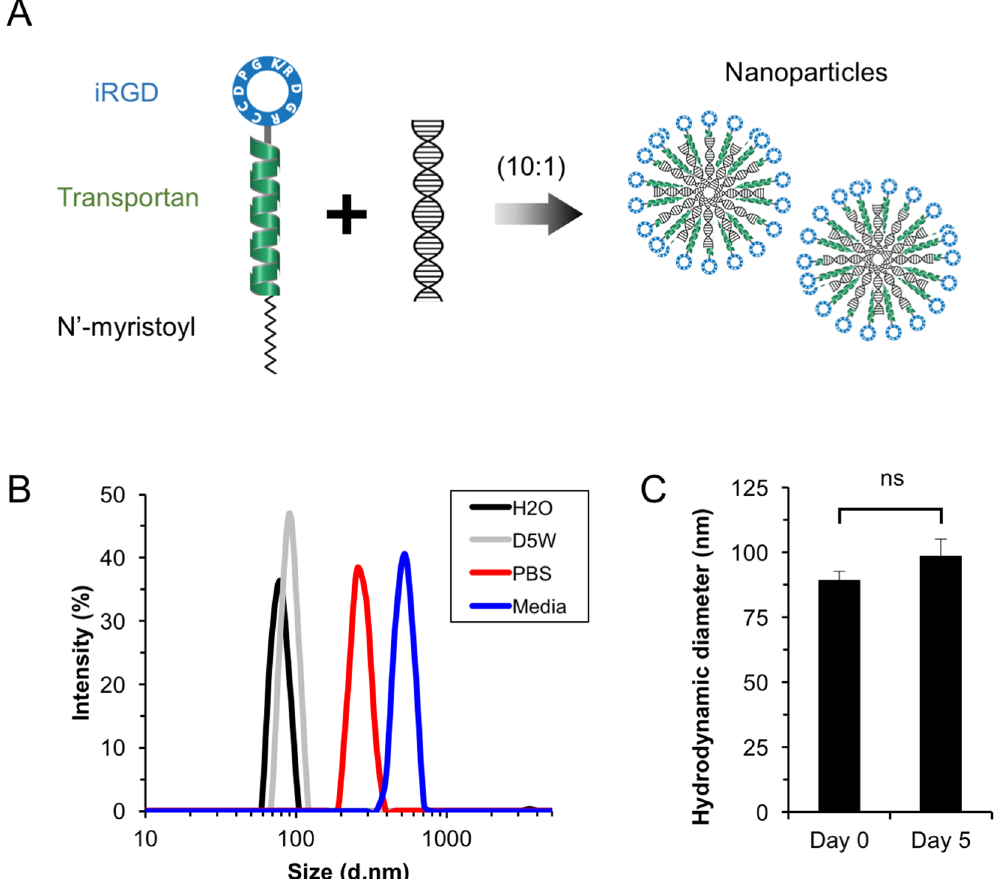
Figure 1. Characterization of iRGD-targeted nanoparticles. ( A ) Schematic of iRGD nanoparticle formation. Tandem peptides consisting of three domains: N-terminal myristoylated acid, cell penetrating peptide domain (Transportan, colored in green), and a cyclic CendR targeting peptide domain (iRGD, CRGDK/RGPDC, colored in blue), is non-covalently mixed with siRNA cargo at a molar ratio of 10:1 (peptide to siRNA) to form nanoparticles as shown. ( B ) Dynamic light scattering (DLS) measurements of hydrodynamic diameter of nanoparticles in pure water (H 2 O, black), 5% dextrose in water (D5W, gray), phosphate buffered saline (PBS, red), or DMEM cell culture media (Media, blue). Representative histograms from 5 independent preparations are shown. ( C ) The hydrodynamic diameter of nanoparticles does not change significantly after incubating for 5 days at room temperature. NS, not significant. Error bars represent standard deviation (n = 5 independent